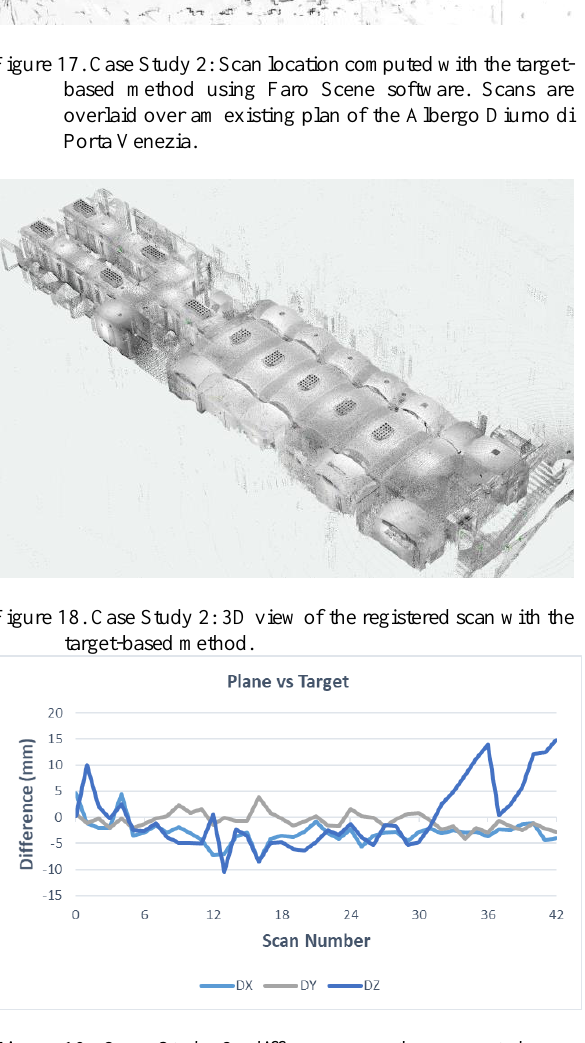
Figure 19. Case Study 2: differences on the computed scan locations between the plane- and target-based methods.